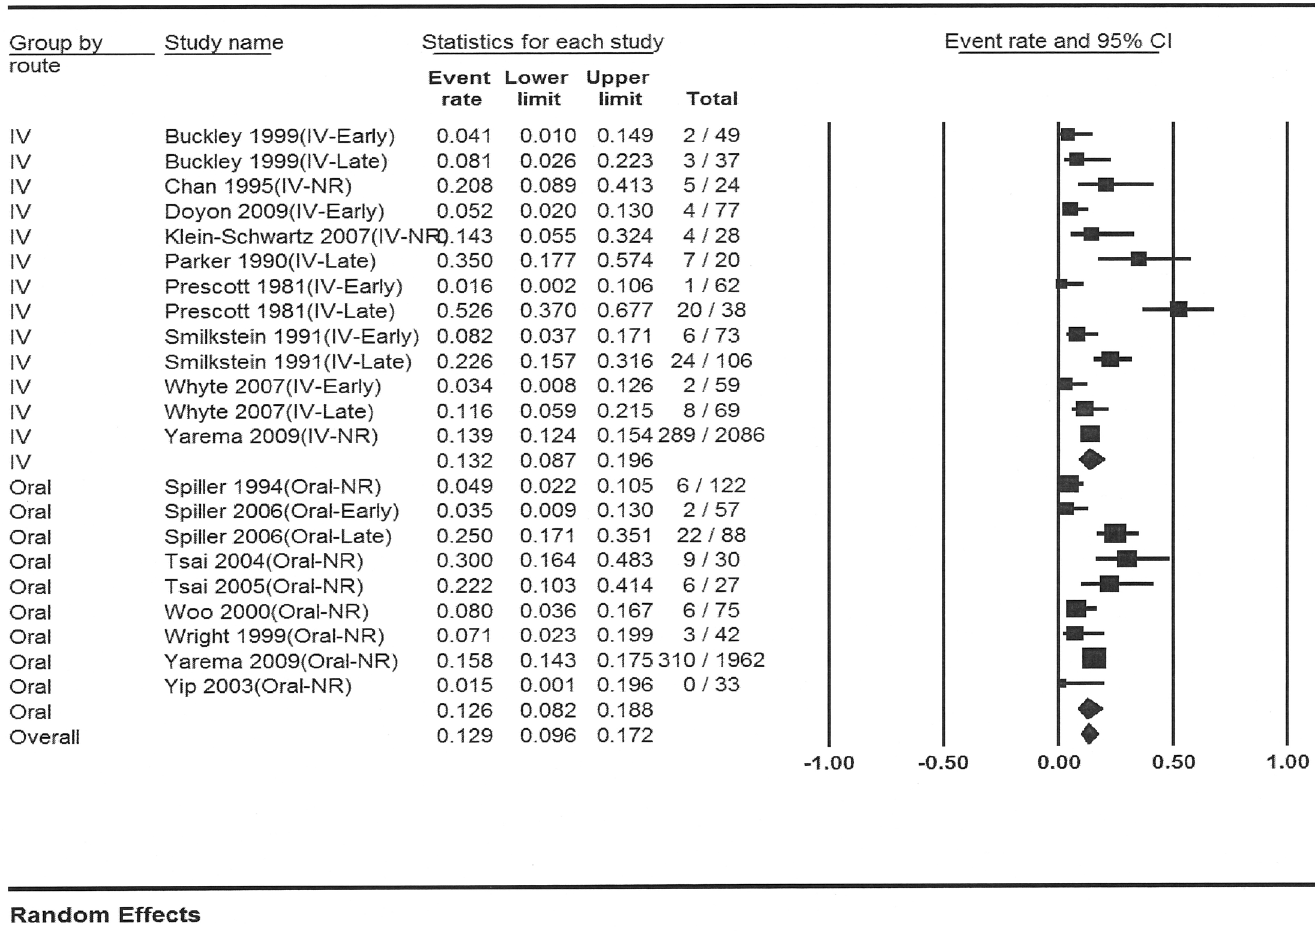
Figure 2. Forest plot showing proportion of patients with acetaminophen poisoning who developed hepatoxicity for intravenous and oral acetylcysteine